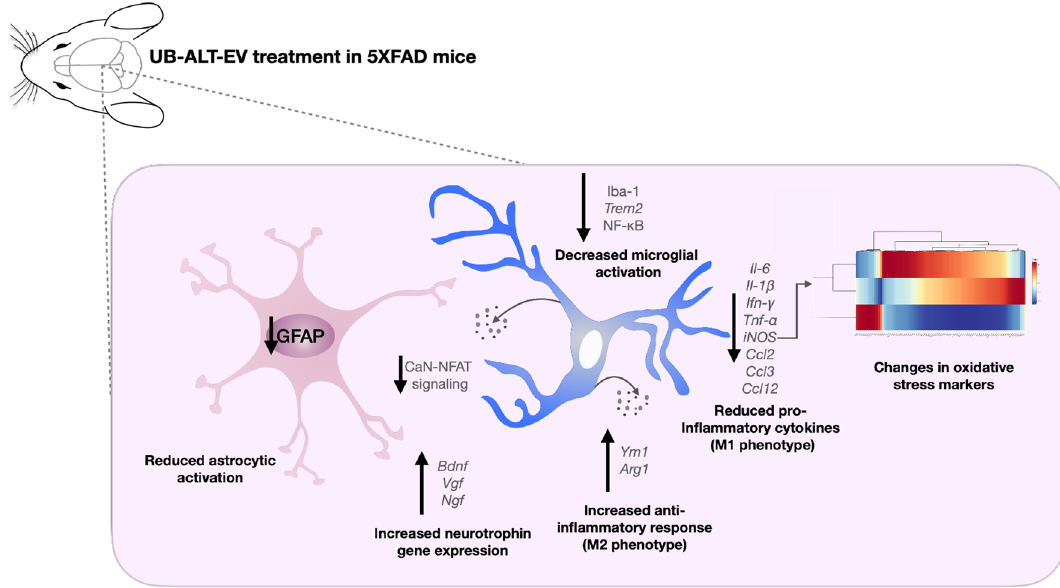
Figure 5. Illustrative cartoon of effects of UB-ALT-EV in 6-month-old 5XFAD mice in oxidative and neuroinflammatory pathology. This figure was generated with Keynote for macOS (ver.